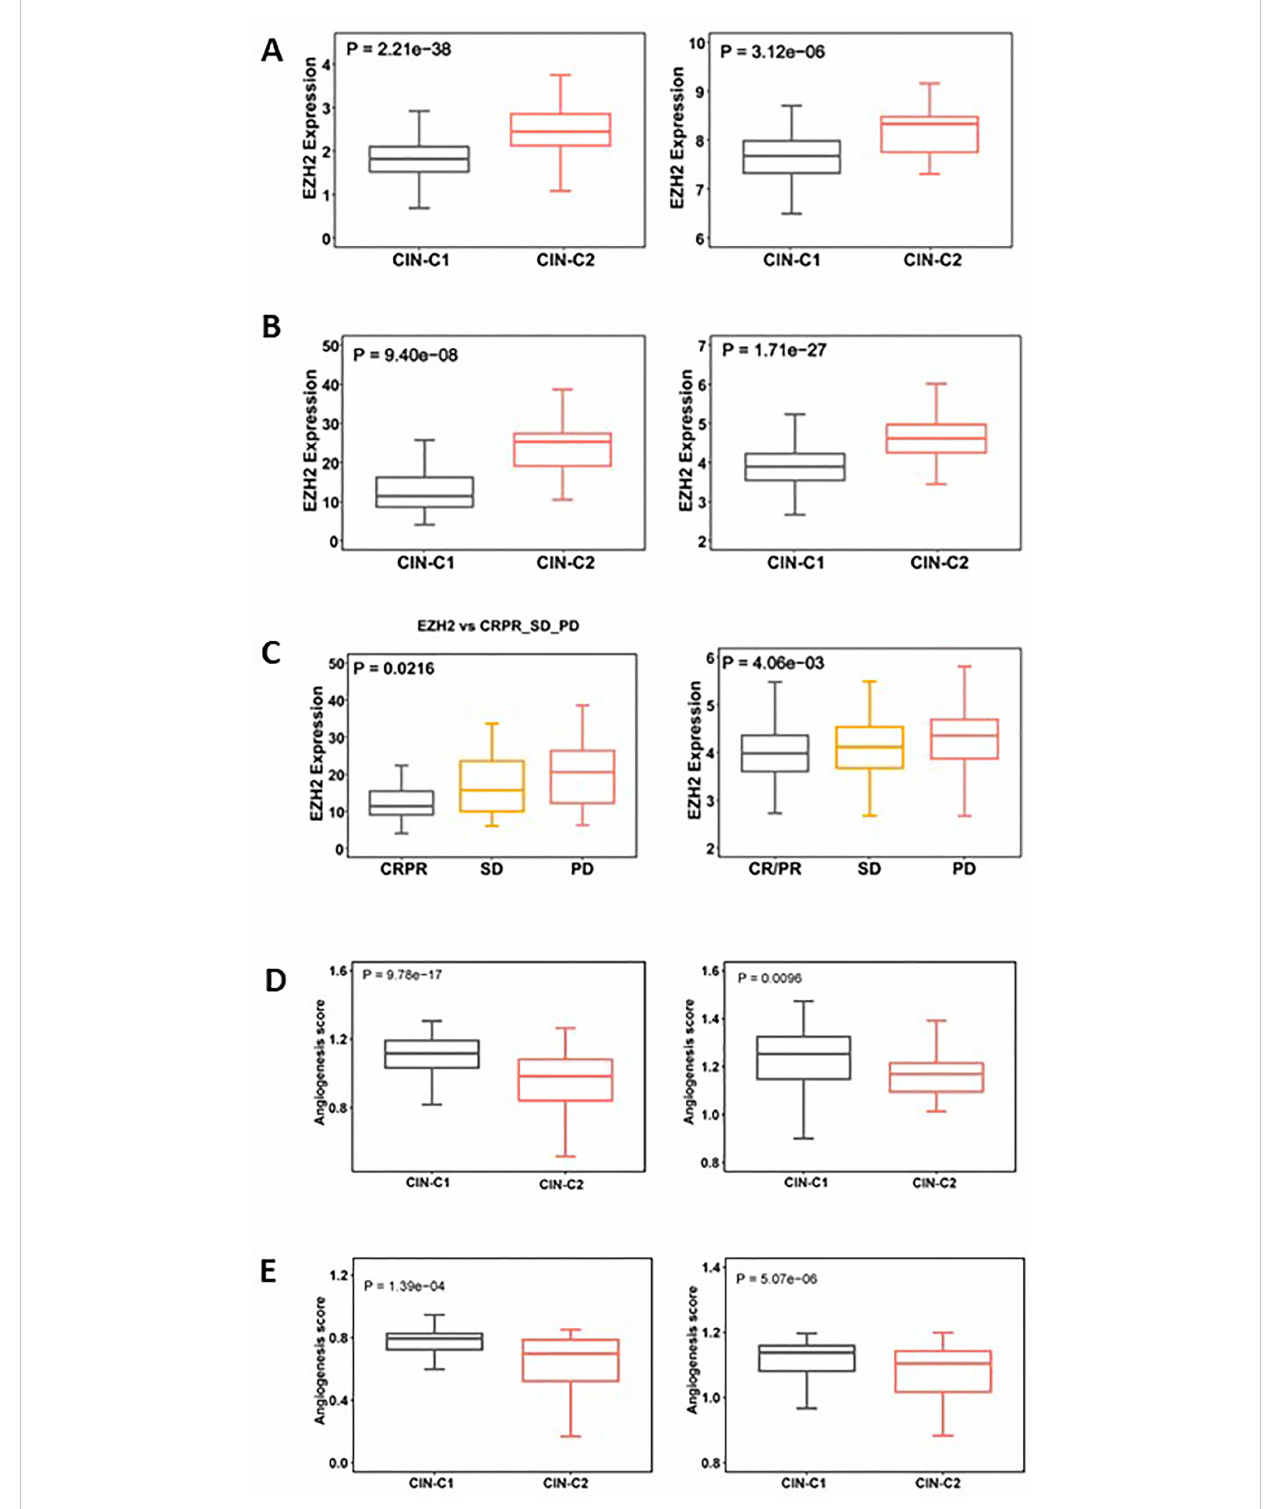
FIGURE 8 Differences in EZH2 expression and angiogenesis between CIN25-C1 and C2 subtypes of ccRCC tumors. (A, B) CIN25-C2 tumors expressed signi fi cantly higher levels of EZH2 mRNA. (A) TCGA (left) and E-MTAB1980 (right) ccRCC cohorts. (B) IMmotion150 (left) and 151 (right) cohorts. (C) Differences in EZH2 expression in tumors from CRPR, SD and PD patients (left and right: IMmotion150 and 151 cohorts, respectively). (D) Lower angiogenesis scores in CIN25-C2 tumors (left and right: TCGA and E-MTAB1980 ccRCC cohorts, respectively). (E) Lower angiogenesis scores in CIN25-C2 tumors (left and right: IMmotion150 and 151 cohorts,